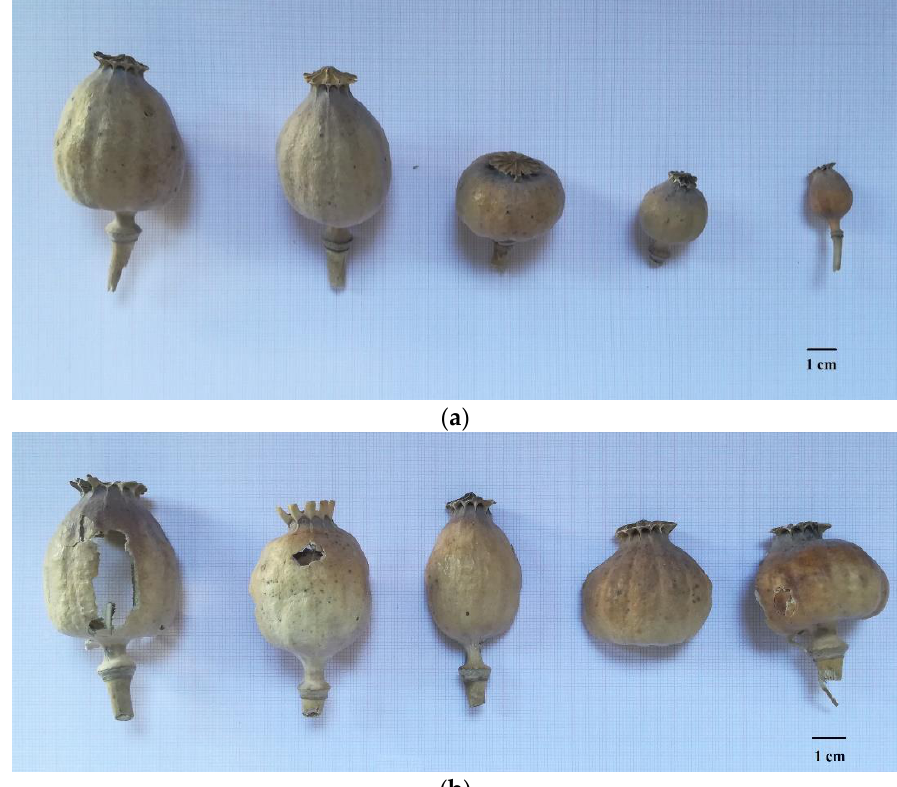
Figure 1. Images of the plant material on millimetric paper (the black bars correspond to 1 cm): representative samples of the sets seized in 2017 ( a ) and in 2018 ( b ).